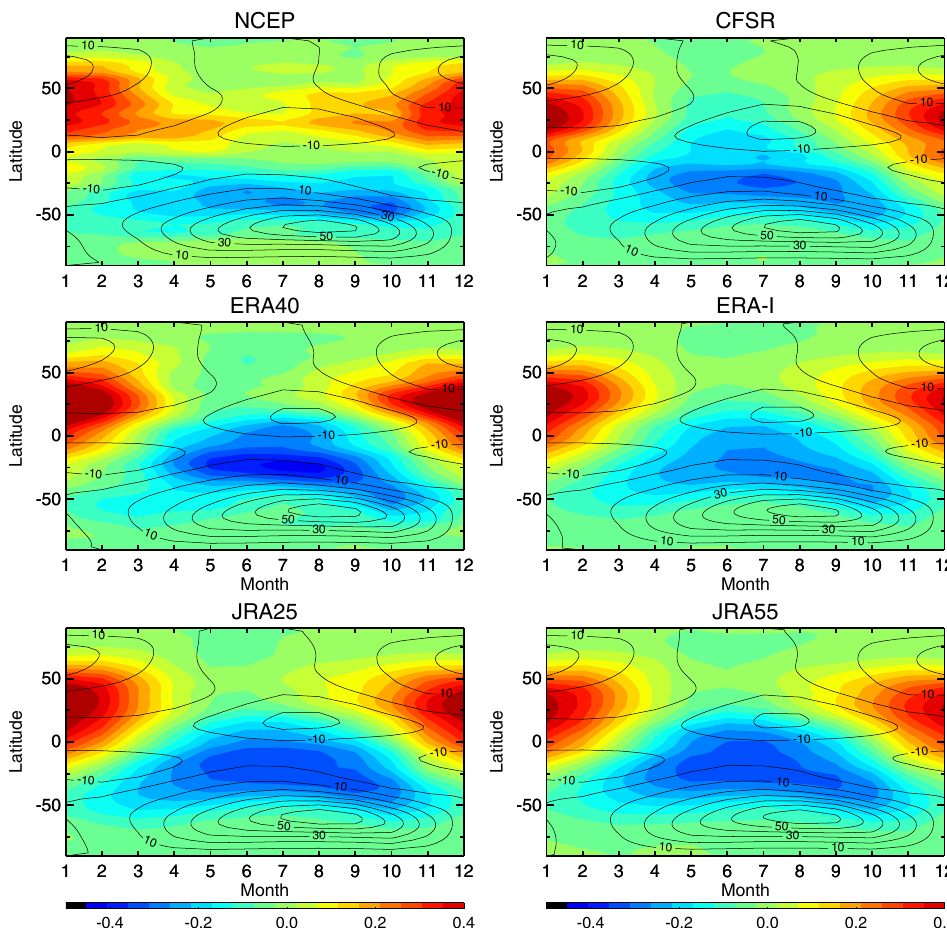
Figure 4. Seasonal variation of the mass stream function (color contours, in 10 10 kgs − 1 ) and zonal mean zonal wind (black contour lines, with intervals of 10ms − 1 ) at